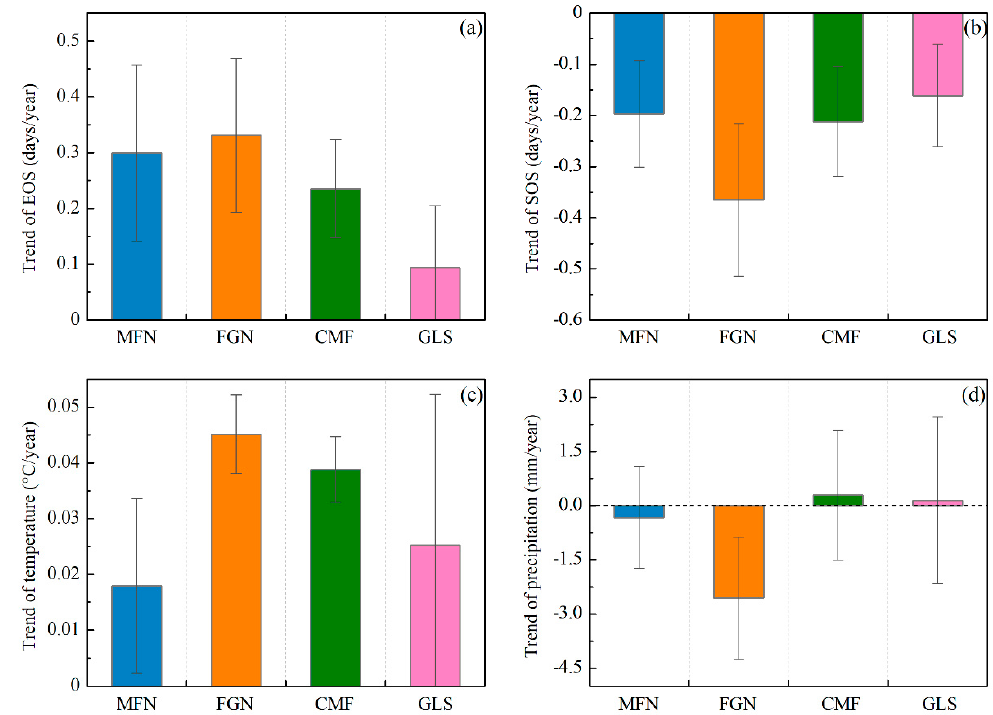
Figure 7. Average trend and standard deviation of EOS ( a ); SOS ( b ); preseason temperature ( c ); and preseason precipitation ( d ) across four ecogeographical regions in the Greater Khingan Mountains from 1982 to 2015.